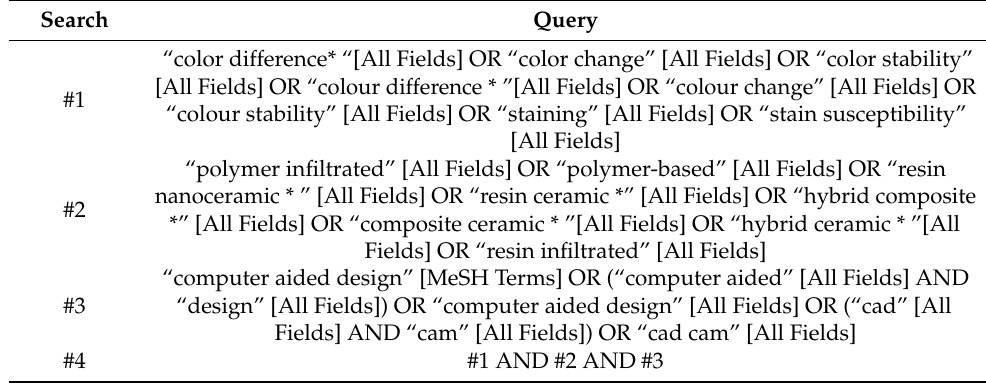
Table 1. Search conducted in Medline/PubMed